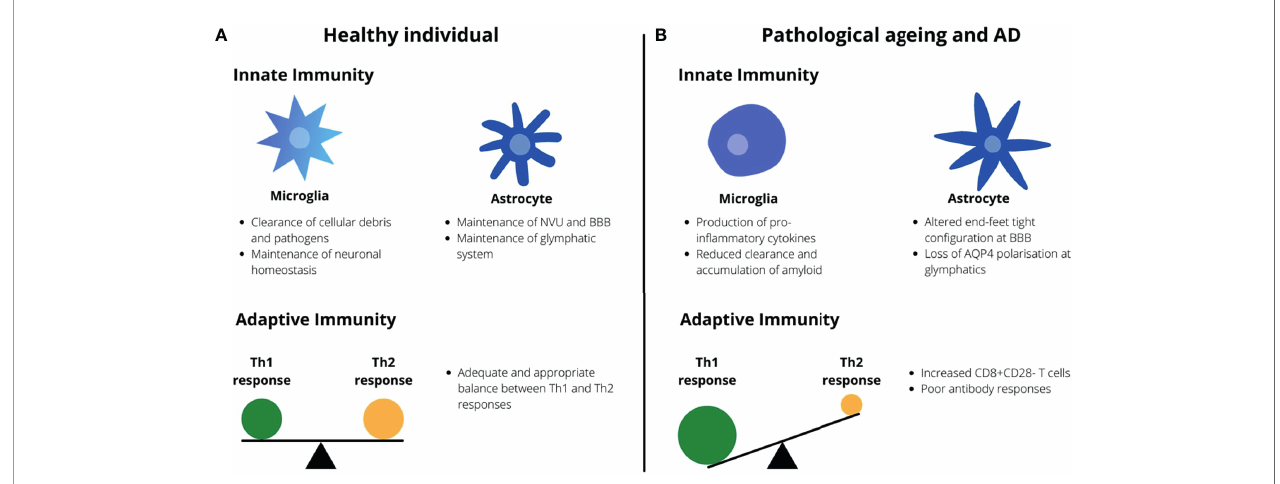
FIGURE 1 | Healthy aging vs . pathological aging and AD. (A) In healthy individuals, microglia serve to provide neurotropic support and maintain neuronal homeostasis whilst astrocytes maintain the BBB and glymphatic system. There is also an appropriate balance between Th1 and Th2 responses by the adaptive immunity. (B) In AD and aging, microglia undergo morphological changes and adopt a pro-in fl ammatory phenotype whilst the capacity for astrocytes to maintain the BBB and glymphatic system is impaired. There is a Th1-skewing of the adaptive immune response with an accumulation of CD8+CD28- T